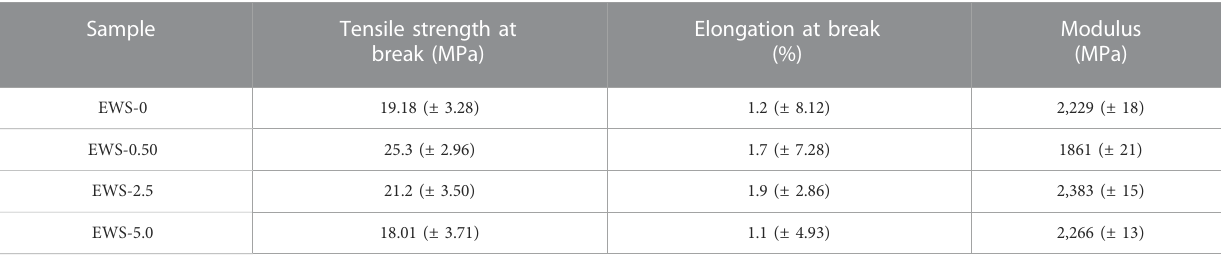
Tensile strength at break (MPa)